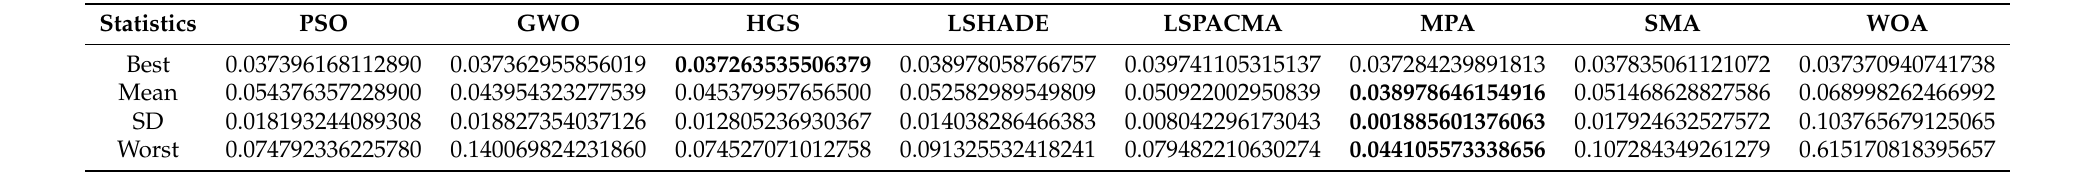
Table 1. Experimental result of RMSE with 20 individuals, 20 evolutions and 30 repetitions.